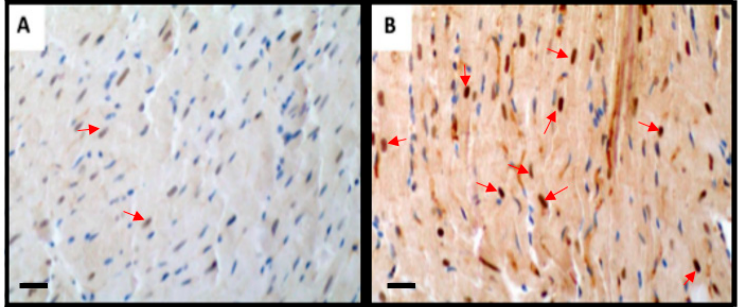
Figure 4. Myocardial nitrotyrosine staining, magnification 20 × , scale bar 100 µ m, blue color representing nuclei, transplanted heart tissue was collected after 24 h of reperfusion for nitrotyrosine localization by immunohistochemistry. ( A ) FTY720-treated group, ( B ) control-saline treated group. Red arrows illustrating decreased expression of peroxynitrite in treated group as compared to control.